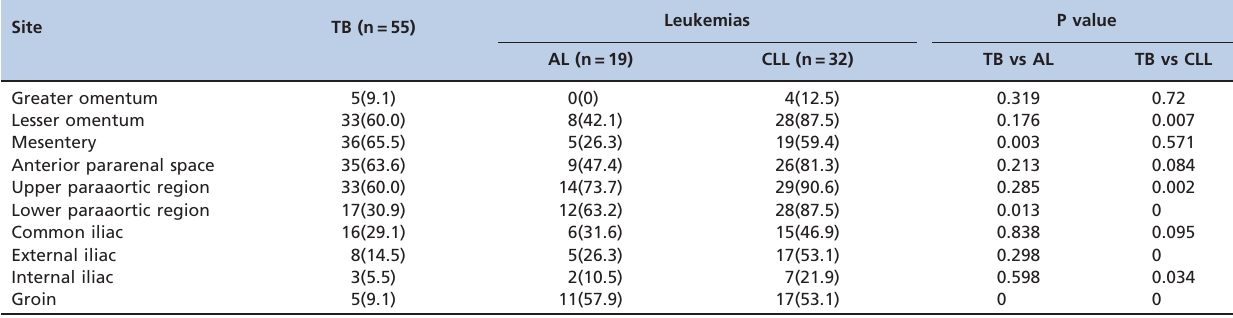
Table 1 - Comparison of anatomic distribution between tuberculosis and leukemias.